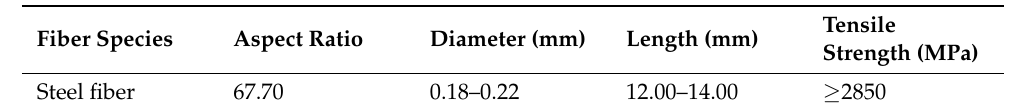
Table 3. Properties of the